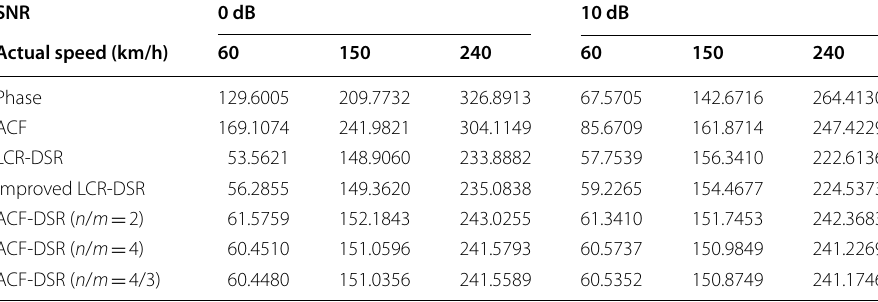
Table 1 The comparison of vehicle speed